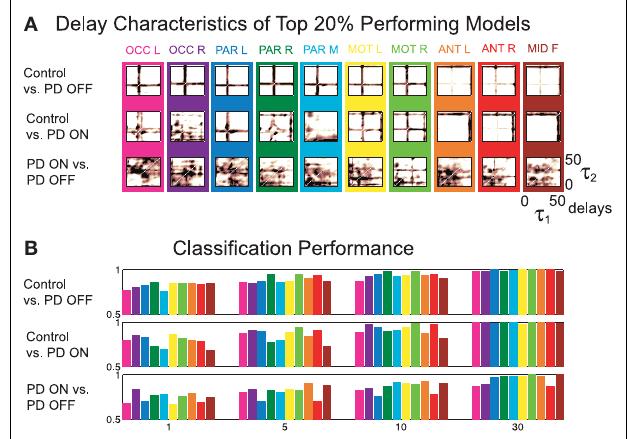
(B) relationship between DDE model output’s distance from a hyperplane, and severity of motor impairment in PD patients, as evaluated by the Unified Parkinson’s Disease Rating Scale (UPDRS). Controls are included to serve as a reference.